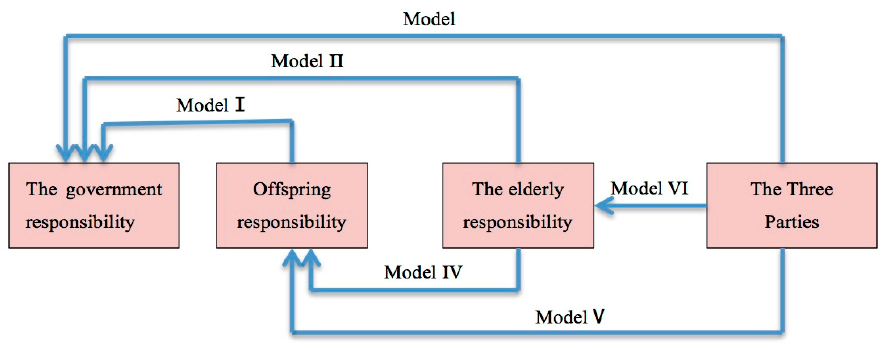
Figure 1. Reference Groups of Six Models. Source: designed by the authors.